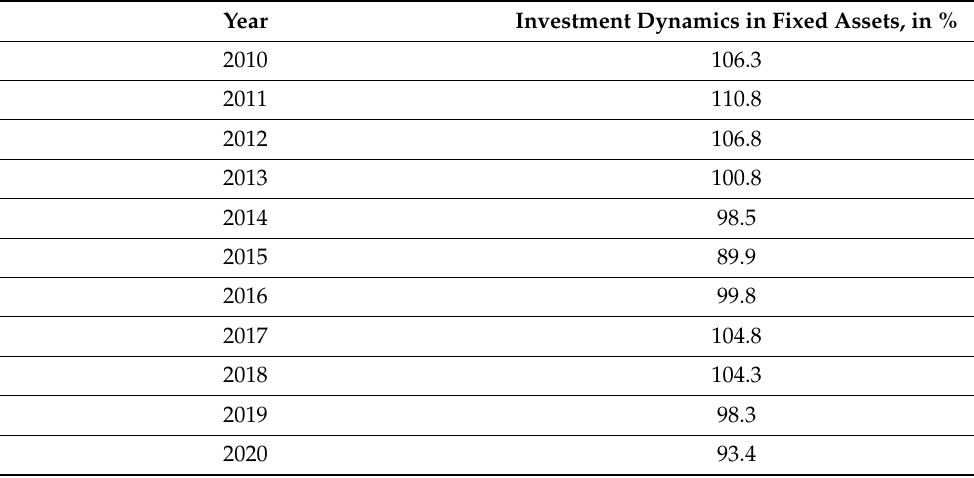
Table 1. Investment dynamics in fixed assets in the Russian Federation